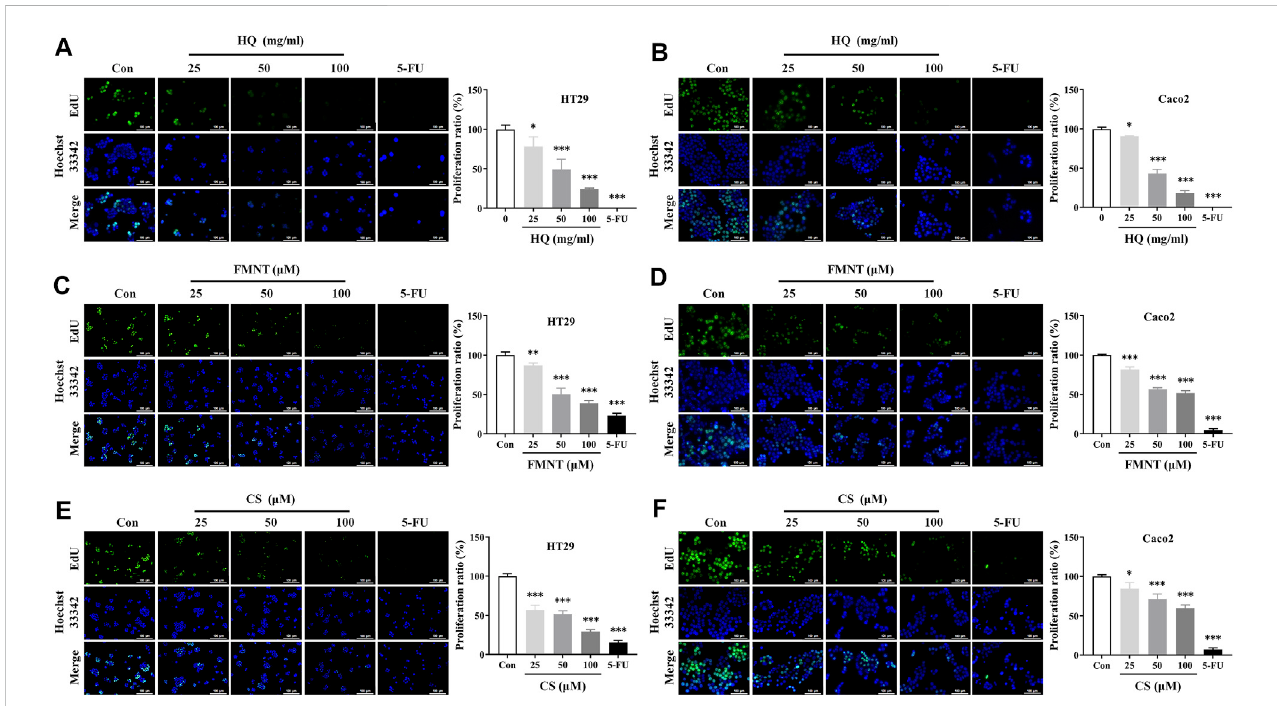
FIGURE 6 HQ, FMNT and CSsigni fi cantly inhibited the proliferation of HT29 and Caco2 cells. The effects of HQ (25, 50 and 100 mg/mL, 48 h) (A and B) , FMNT (25, 50 and 100 μ M, 48 h) (C and D) and CS (25, 50 and 100 μ M, 48 h) (E and F) on the proliferation of HT29 and Caco2 cells, respectively. 5-FU was used as a positive control for inhibition ofcell proliferation. The data represent themean ± SD ( n = 3). * p < 0.05, ** p < 0.01 and *** p < 0.001 comparedwith the control